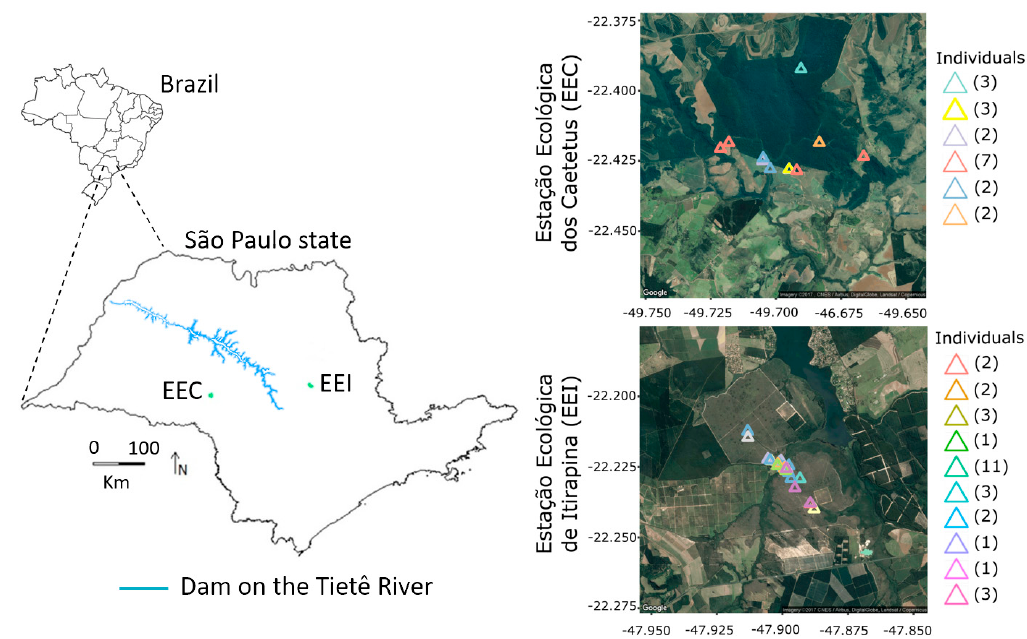
Figure 1. Map of the study area with a representation of the hydropower’s dams along the Tietê River and the distribution of the individual scat samples. The numbers in parentheses indicate the number of times that the same individual was sampled. EEC: Estação Ecológica dos Caetetus; EEI: Estação Ecológica de Itirapina.